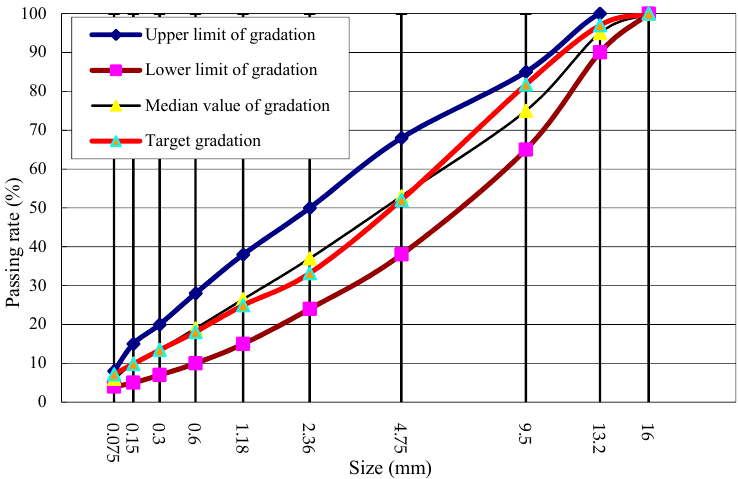
Figure 3. Grading curve of AC-13 steel wool fibers modified basalt asphalt mixture.